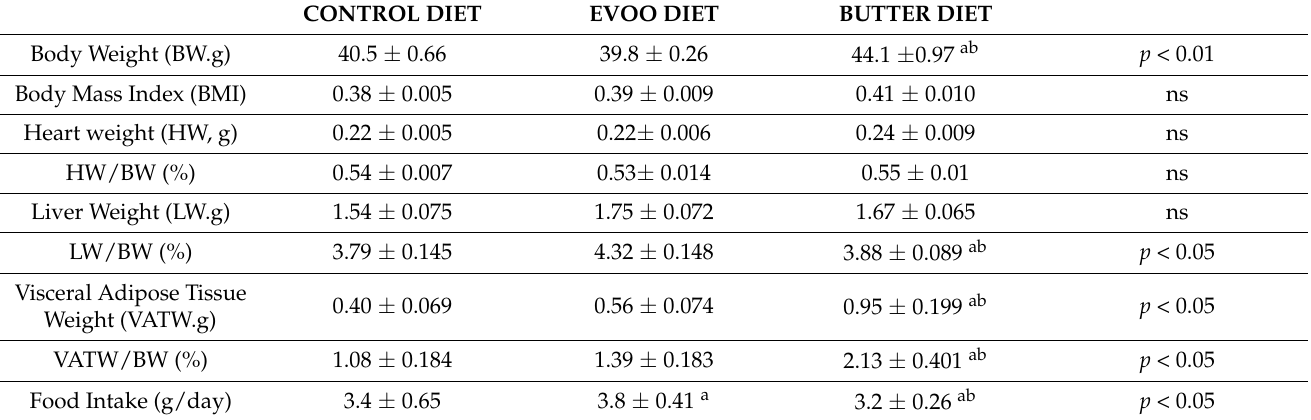
Table 1. Mean values ± standard errors of the mean (SEMs) of daily food intake (g/day), finally body weight (BW, g), and Body Mass Index (BMI) and heart (HW), liver (LW), and total visceral adipose tissue (VATW), expressed as grams and percentage of body weight (HW/BW, LW/BW, and VATW/BW) for the three groups of animals (the control diet, the butter diet, and the Extra Virgin Olive Oil (EVOO) diet). a: significant differences between the EVOO, butter, and control diets. b: significant differences between EVOO and Butter.3.2. Leptin and Ghrelin Fasting and Postprandial Plasma Levels.